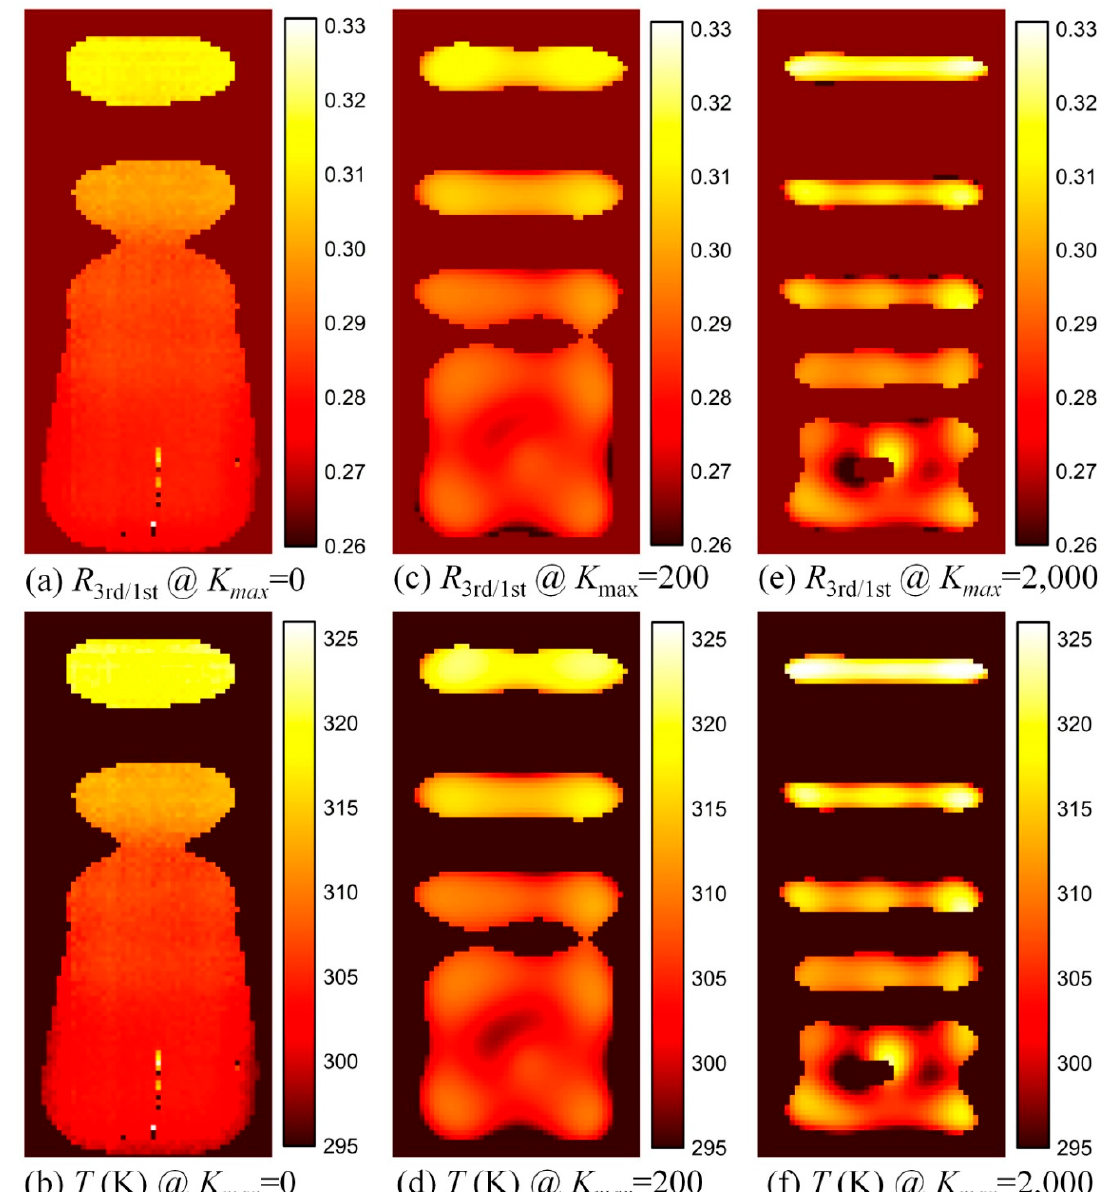
Figure 4. Deconvolved spatial distributions of harmonic ratio (the first row) and temperature (the second row) for different K max values. ( a ), ( c ) and ( e ) show the deconvolved spatial distributions of (the second row) for different K max values. ( a , c , e ) show the deconvolved spatial distributions of harmonic ratio, whereas ( b ), ( d ) and ( f ) show the deconvolved spatial distributions of temperature. harmonic ratio, whereas ( b , d , f ) show the deconvolved spatial distributions of